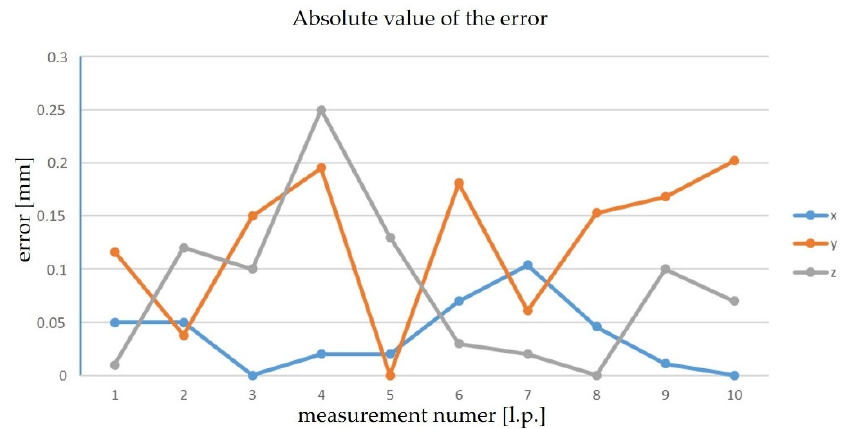
Figure 17. Error plots of the coordinates of points.